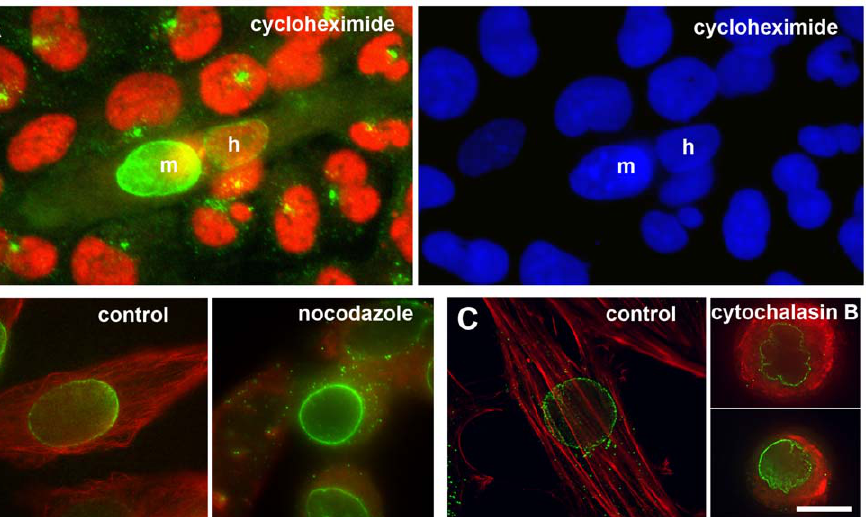
Figure 6. Recruitment of centrosome proteins to the perinuclear area occurs independently of new protein translation, or polymerized microtubules, or F-actin. (A) Heterokaryon of a fused U2OS cell with a differentiated H-2K b -tsA58 cell, in the presence of 10 m M cycloheximide. Immunofluorescence of PCM-1 (green) and human NuMA (red) is shown. ‘‘m’’ and ‘‘h’’ indicate the nuclei contributed from the mouse H-2K b -tsA58 cell, or from the human U2OS cell, respectively. A significant amount of the centrosome protein PCM-1 is seen accumulating around the human nucleus in the heterokaryon, but not in the unfused human U2OS cells. DNA is stained with DAPI (blue). (B) Left: differentiating control H-2K b - tsA58 cell, stained for microtubules (red), and PCM-1 (green). Right: H-2K b -tsA58 cell that differentiated for two days in the presence of 1 m M nocodazole, to depolymerize microtubules. (C) Left: differentiating control H-2K b -tsA58 cell, stained with rhodamine-labelled phalloidin for polymerized actin (red), and with an antibody against PCM-1 (green). Right: two H-2K b -tsA58 cells that differentiated for two days in the presence of 10 m g/ml cytochalasin B, to depolymerize actin. Bar in (c), 10 m m.